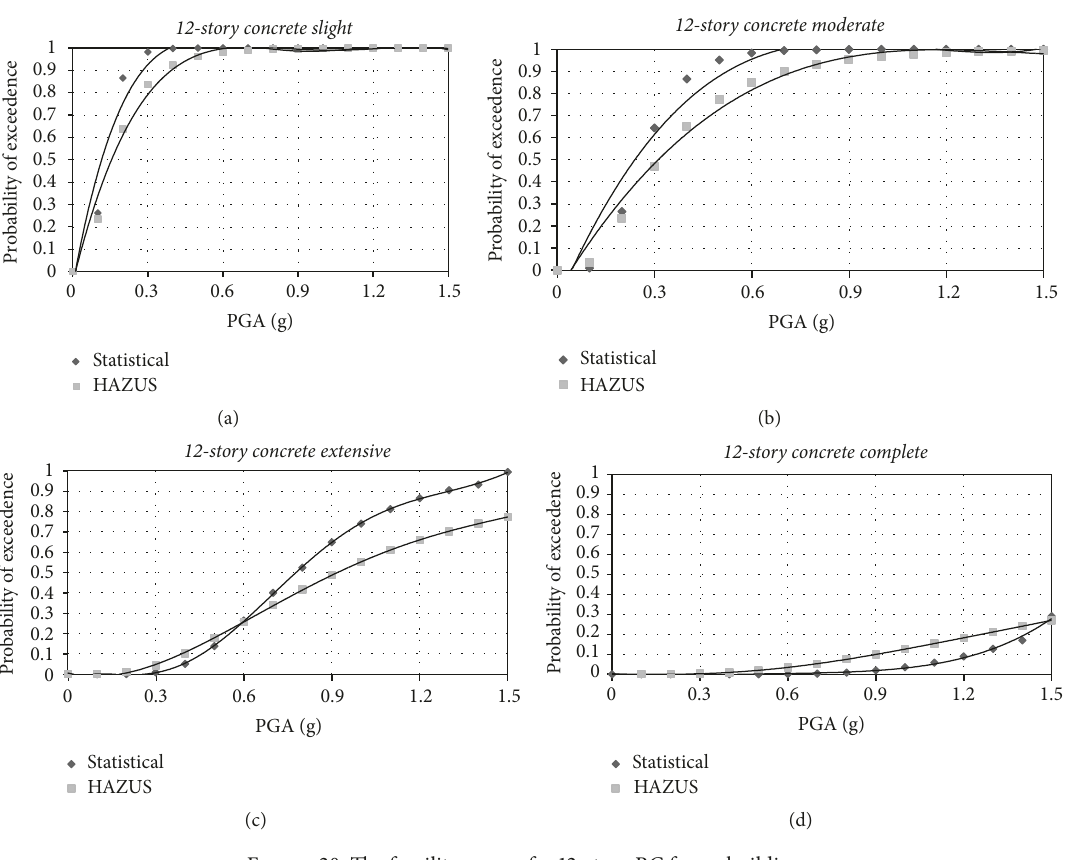
Figure 20: The fragility curves for 12-story RC frame buildings.